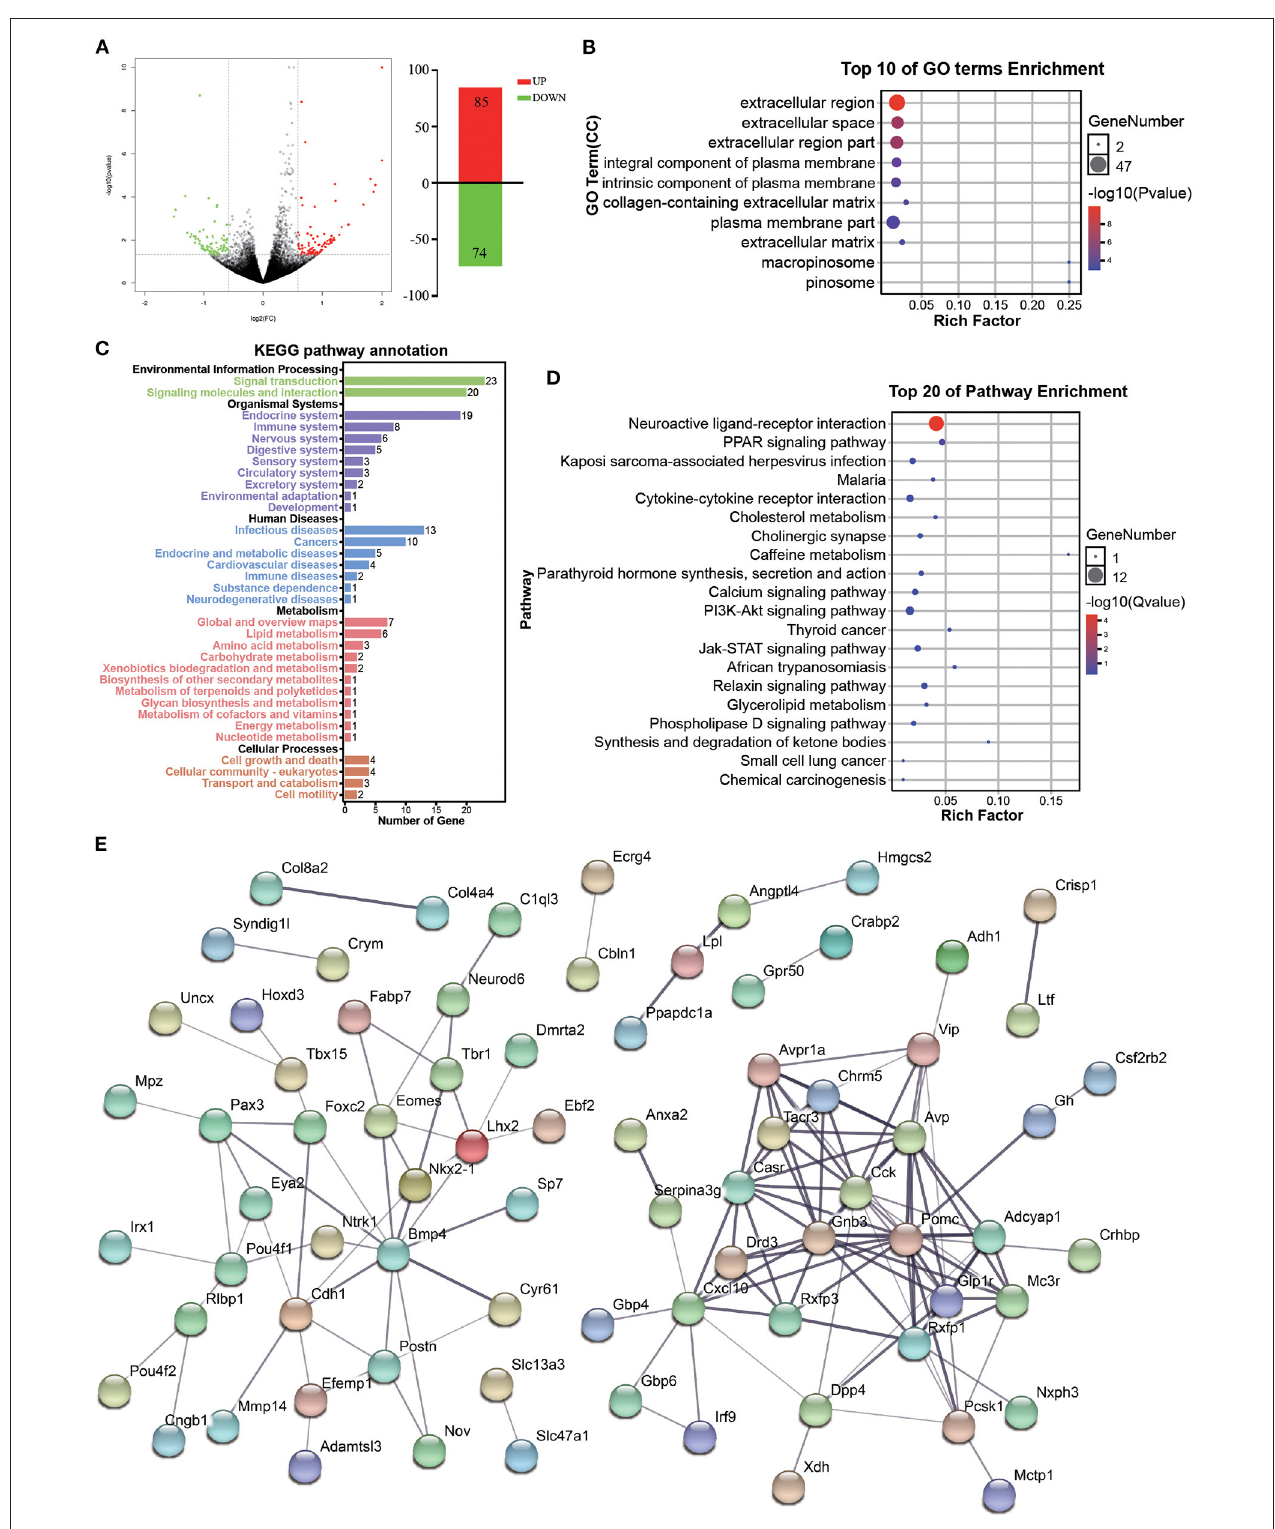
FIGURE 5 | Functional analysis of DEGs associated with accompanying with companion in VTA. (A) The MA plot displays the DEGs distribution between CUMS-resilience mice and Companion-resilience mice, the column chart on the right is the number of statistical DEGs. (B) The histogram demonstrates DEGs GO enrichment results, CC (cellular component). (C) KEGG pathway annotation for DEGs. (D) The histogram demonstrates DEGs KEGG pathway enrichment results, top 20 of pathway enrichment were given. (E) PPI network of the DEGs visualized by Cytoscape.